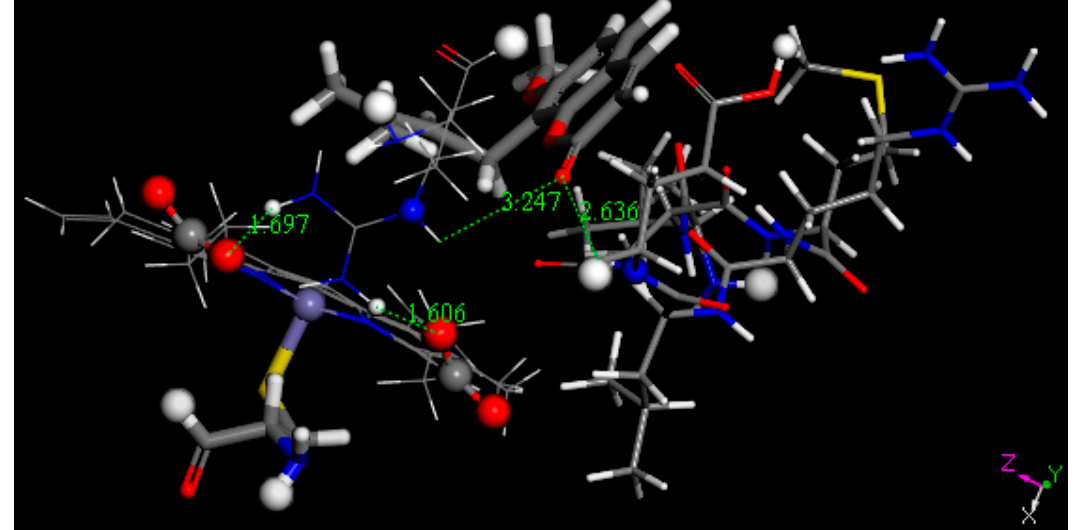
Figure 16. Docked pose 3 of osthole after DFT geometry optimization calculations.